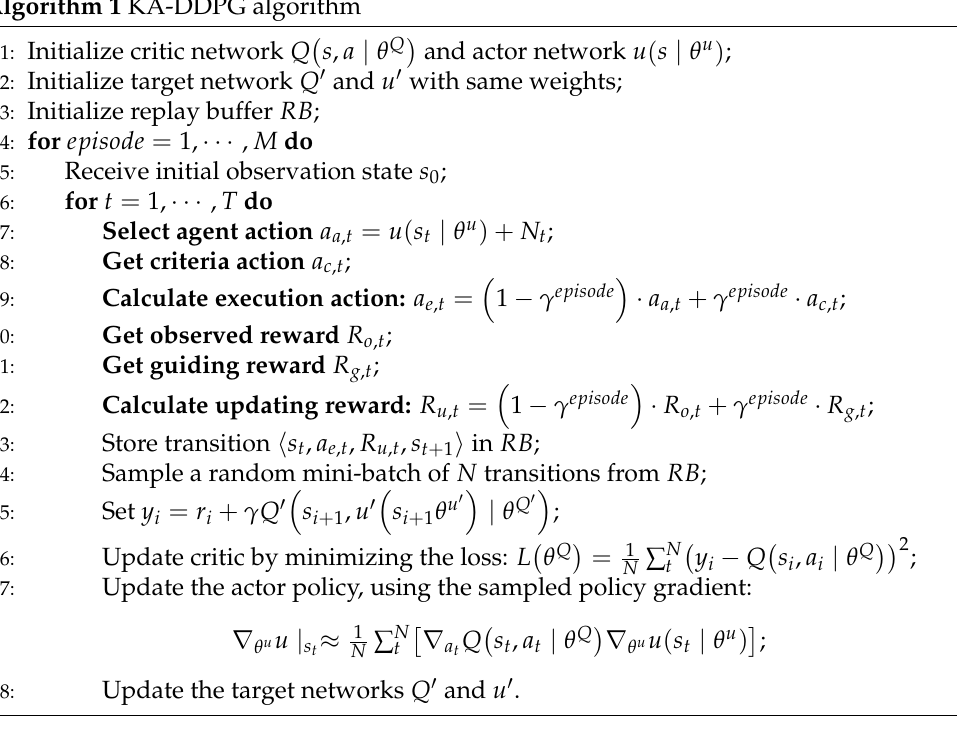
Algorithm 1 KA-DDPG algorithm